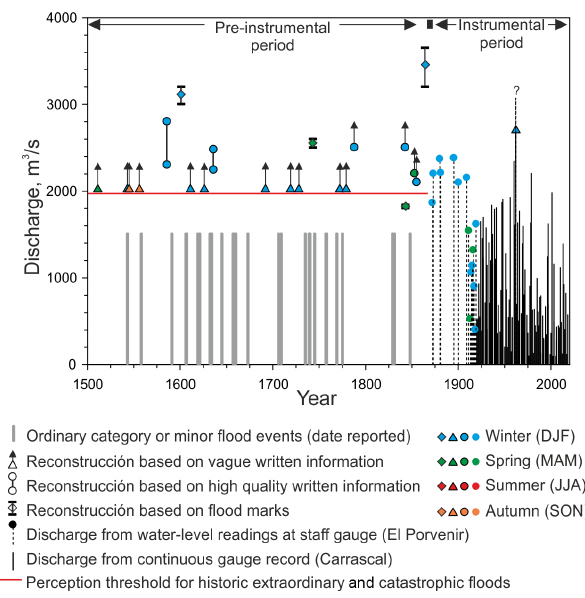
Figure 6. The 1500–2018 Duero River flood discharges based on documentary (historic) water-level readings on staff gauges (El Porvenir) and continuous gauging (El Carrascal). Documentary floods with damaging overflows (catastrophic and extraordinary cat- egories) exceeded a threshold discharge of 1900m 3 s − 1 . Discharge reconstruction was performed based on different description details (from vague to high-quality) and flow depth reported at specific flooded sites and with epigraphic marks (types described in leg- end). Reported ordinary floods were estimated below the discharge threshold. The flood season is indicated by colours as in the legend.